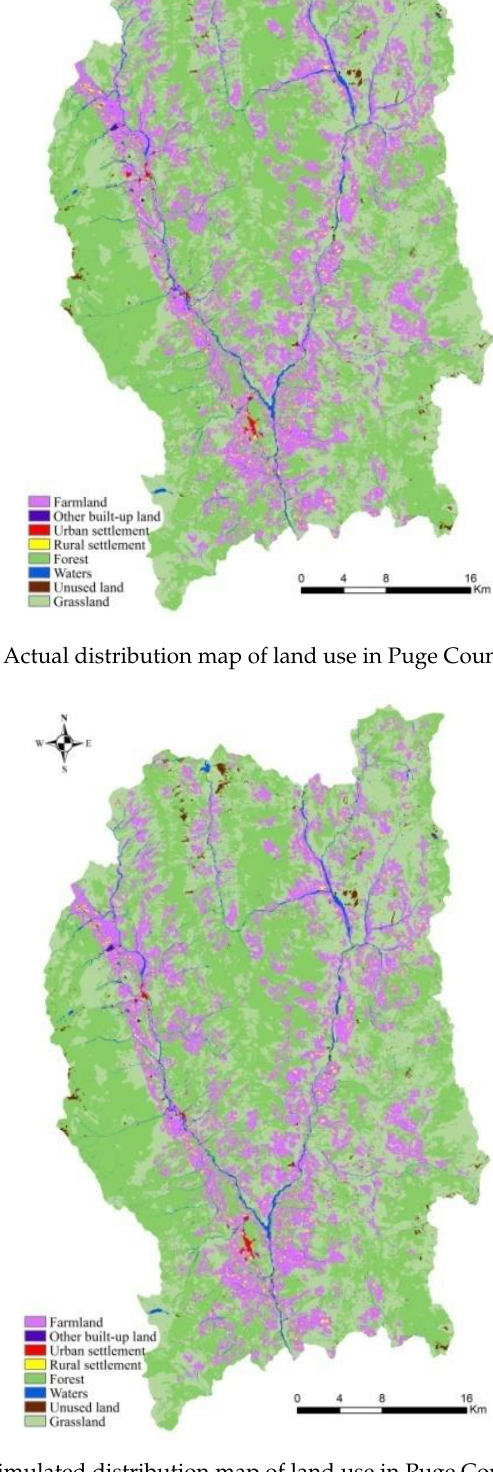
Figure 9. Simulated distribution map of land use in Puge County in 2017.